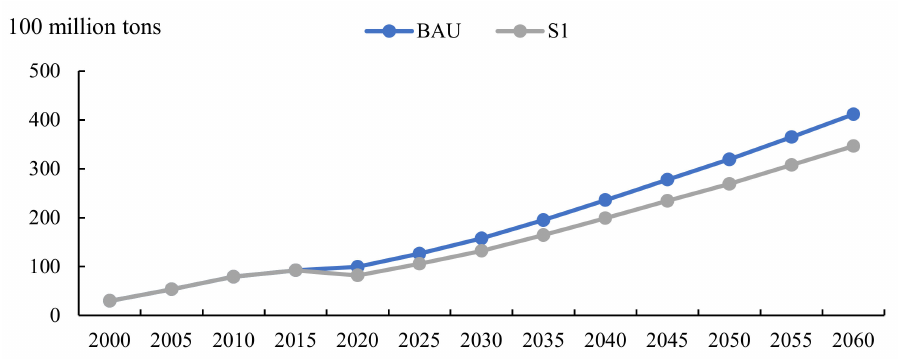
Figure 7. Carbon emissions under carbon price policy S1 from 2020 to 2060.